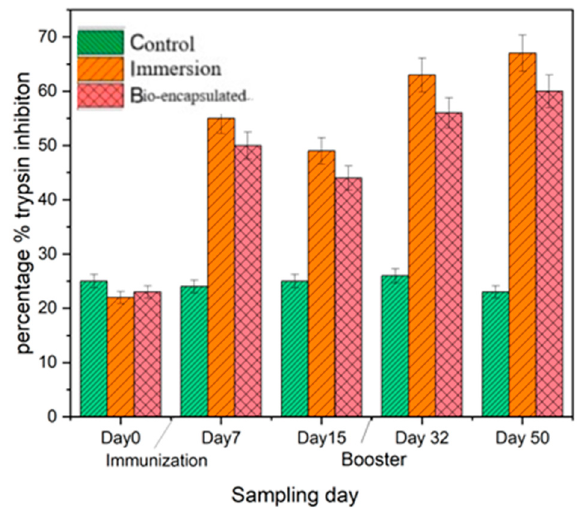
Figure 7. Serum antiprotease activity of the juvenile Cyprinus carpio L. in all three groups, control, bio-encapsulated and immersion at day 0, 7, 15, 32 and 50.